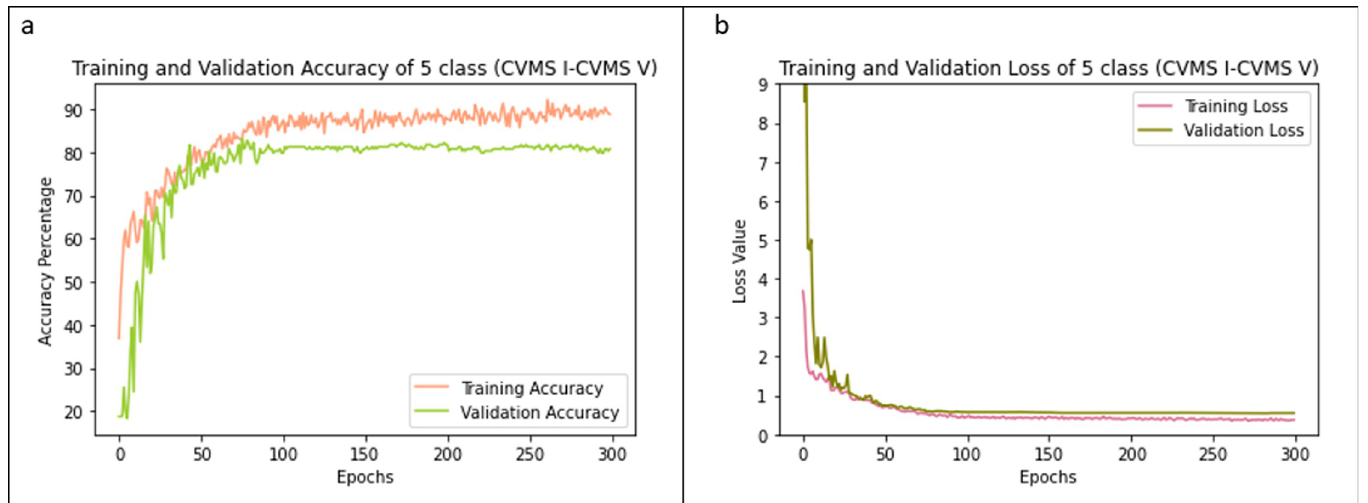
Fig 4. Training and validation accuracy and losses for 5-stage classification. The accuracies (a) and losses (b) of CNN model with the directional filters obtained by averaging 5 folds are shown.